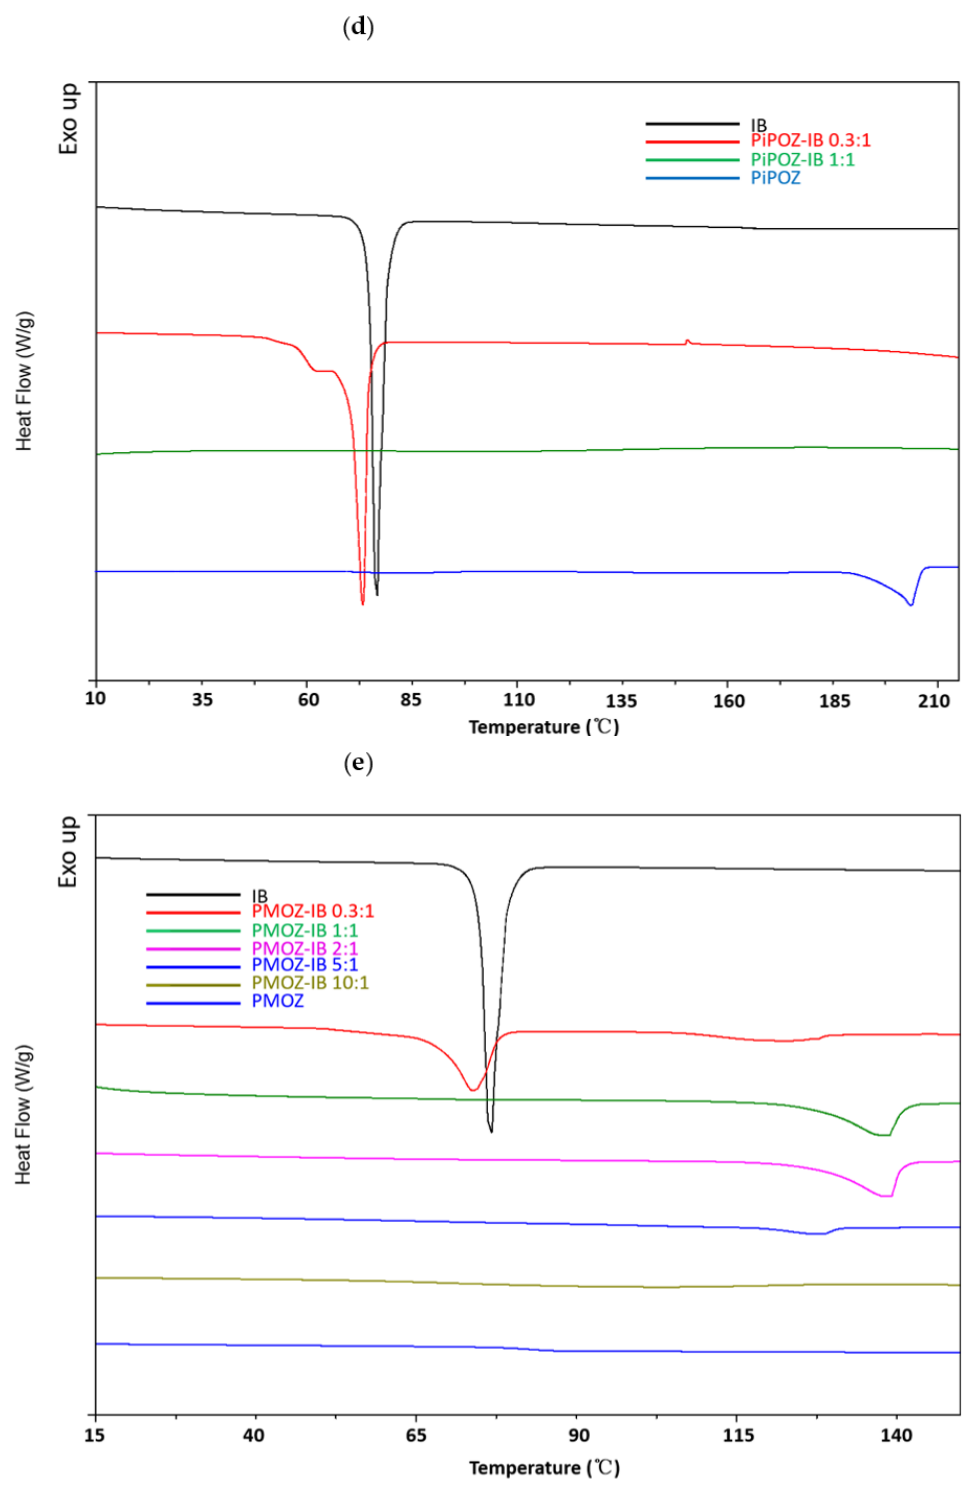
Figure 3. DSC thermograms of PVP-IB SDs ( a ), PEOZ-IB SDs ( b ), PnPOZ-IB SDs ( c ), PiPOZ-IB SDs ( d ), and PMOZ-IB SDs ( e